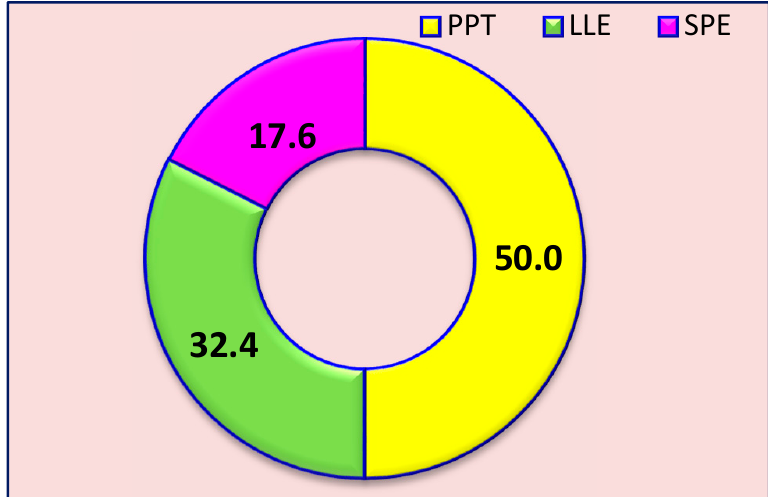
Figure 2. Distribution of sample preparation assays. PPT: protein precipitation; LLE: liquid-liquid extraction; SPE: solid phase extraction.